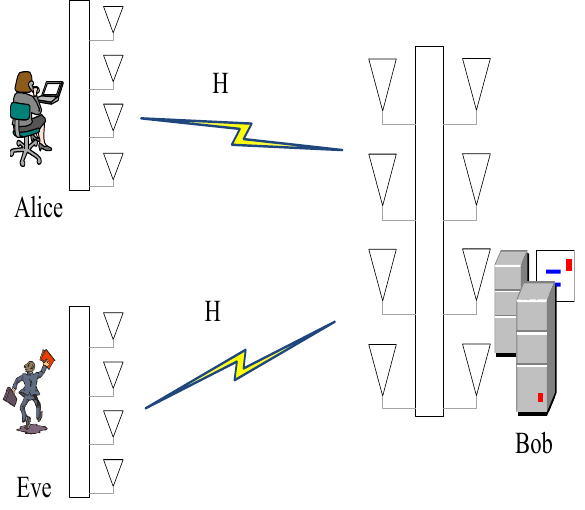
Figure 2. Scenario with Alice ( T E ), Bob ( ED ), and